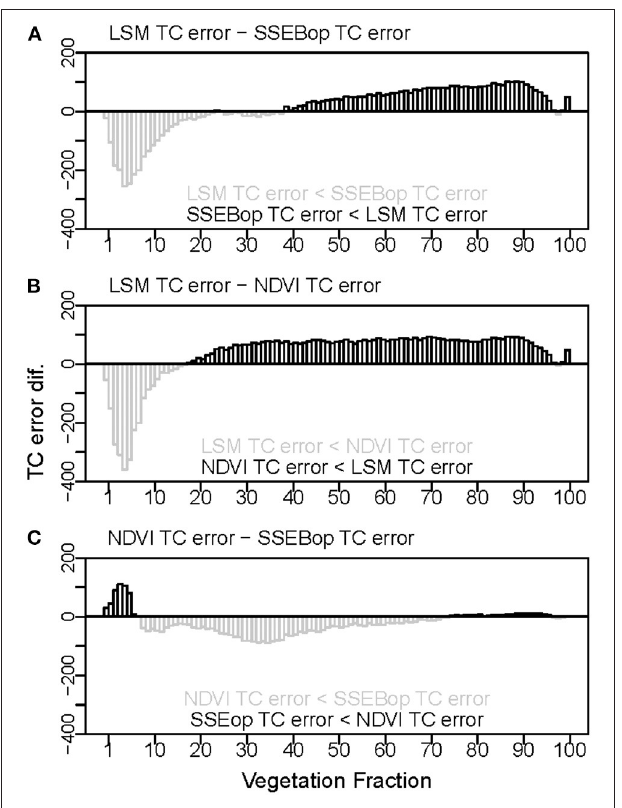
FIGURE 9 | Average TC error difference as a function of vegetation fraction for (A) LSM ET TC error minus SSEBop ET TC error, (B) LSM ET TC error minus NDVI TC error, and (C) NDVI TC error minus SSEBop ET TC error.